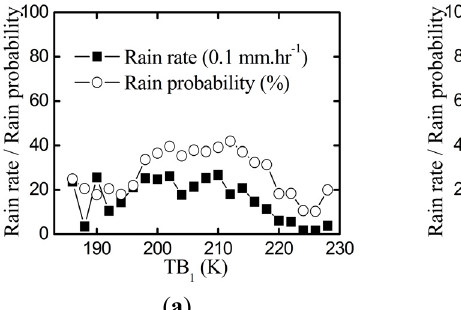
Figure 1. The relationship between cloud pixel characteristics and precipitation in the Huaihe River Basin (HRB). ( a ) Precipitation characteristic of top brightness temperature (TB) for infrared channel 1 (IR ) (10.3–11.3 μ m); ( b ) and ( c ) are the same as ( a ) but for 1 channel IR (11.5–12.5 μ m) and channel WV (6.3–7.6 μ m); ( d )–( f ): the same as ( a )–( c ) 2